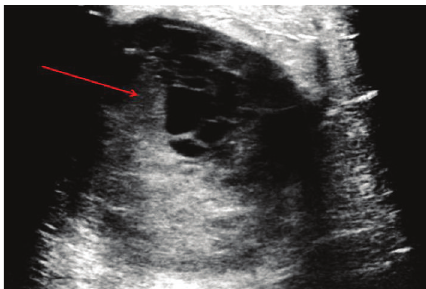
Figure 3: A seven-centimeter fluid lobulated lesion with septations and hypoechoic